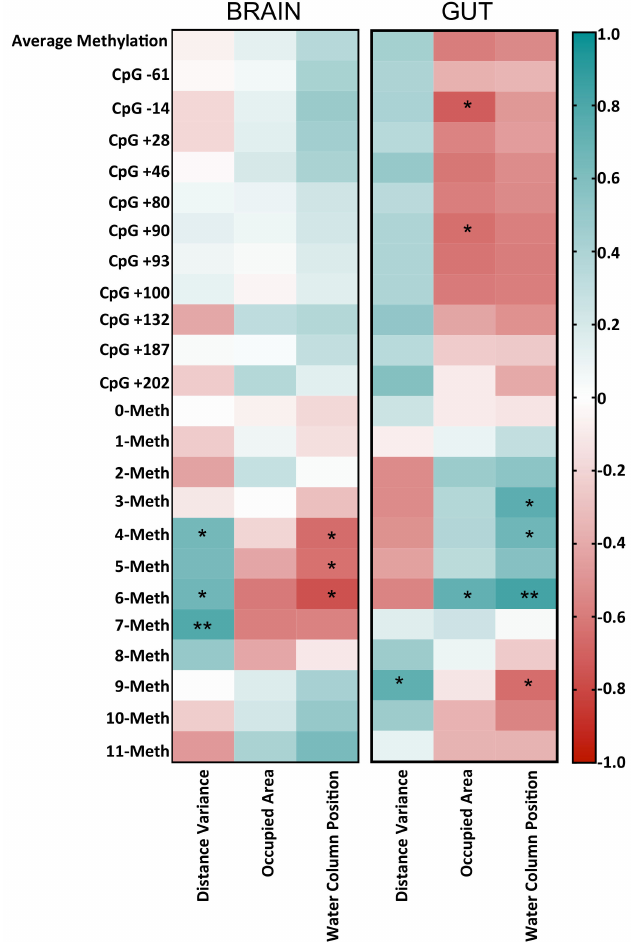
Figure 6. Correlogram showing Pearson correlation between DNA methylation data and behavioral parameters. The graph reports r values derived from Pearson correlation between average methylation, single-CpG methylation, epiallele classes and distance variance, occupied area and water column positions. The scale color from blue to red indicates a positive to negative correlation ( − 1 ≤ r ≥ 1). Statistical analyses were performed using a Pearson correlation test (* p ≤ 0.05; ** p ≤